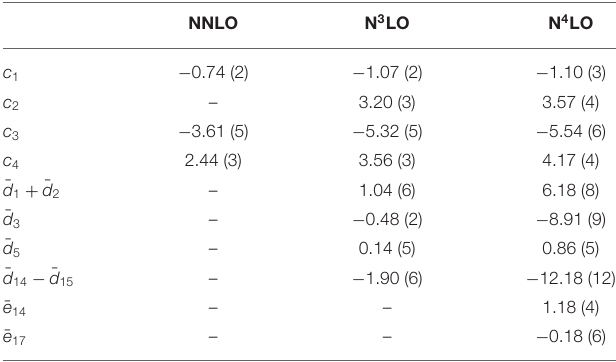
TABLE 3 | The π N LECs as determined in the Roy-Steiner-equation analysis of π N scattering conducted in Hoferichter et al. [86]. NNLO N 3 LO N 4